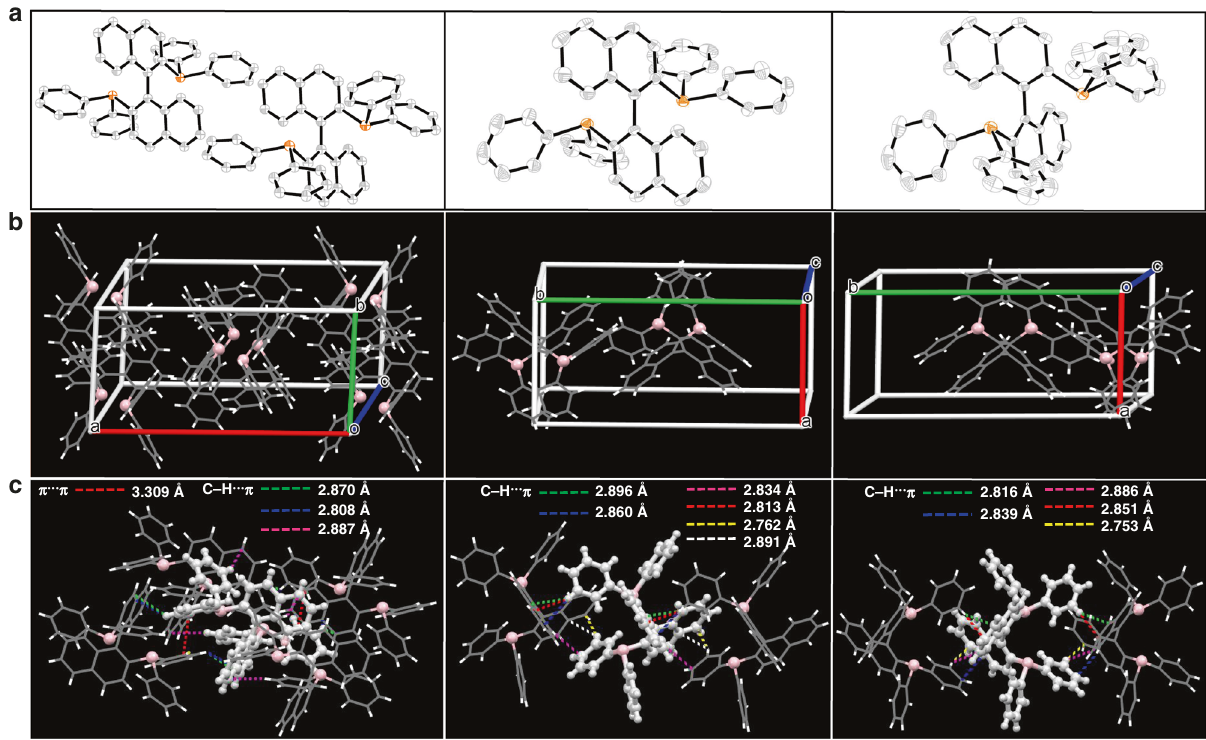
Fig. 1 Structural information of BINAP in crystal. a Molecular structure of rac- BINAP (left), R- (central) and S- BINAP (right) in crystal. b Molecular packing of BINAP in different con fi gurations from left (rac- BINAP ), central (R- BINAP ), and right (S- BINAP ) in a crystal unit cell. c Intermolecular interactions of single molecule with adjacent ones from left (rac- BINAP ), central (R- BINAP ), and right (S- BINAP